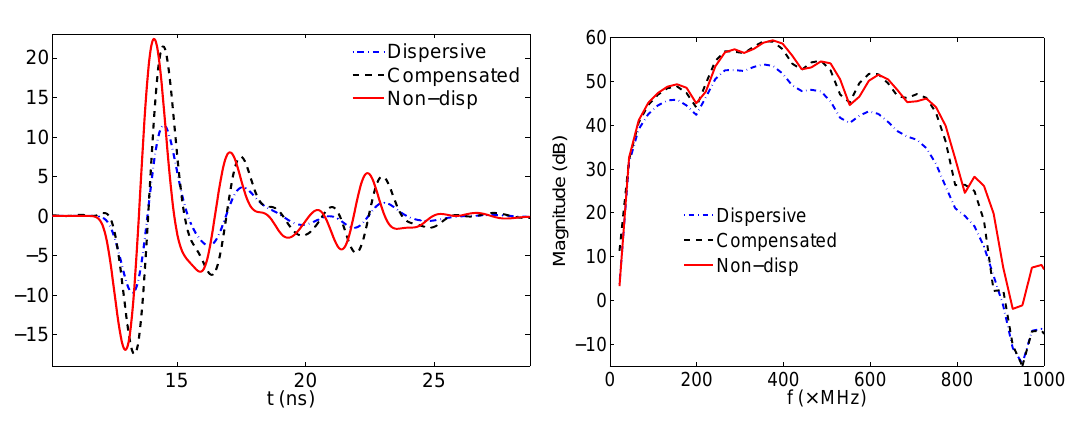
Figure 16. Signal received by one of the TRA antennas in dispersive medium, correspond- ing compensated signal and the reference signal that would be received in non-dispersive medium in (left) time and (right) frequency